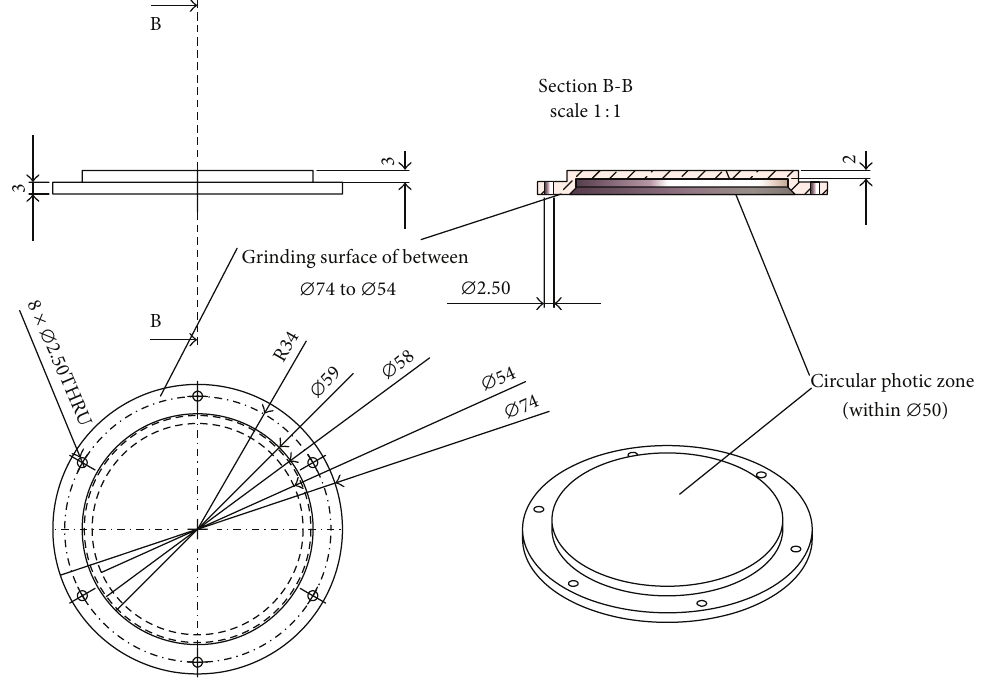
Figure 5: The engineering drawing for upper cover of cell culture cavity.